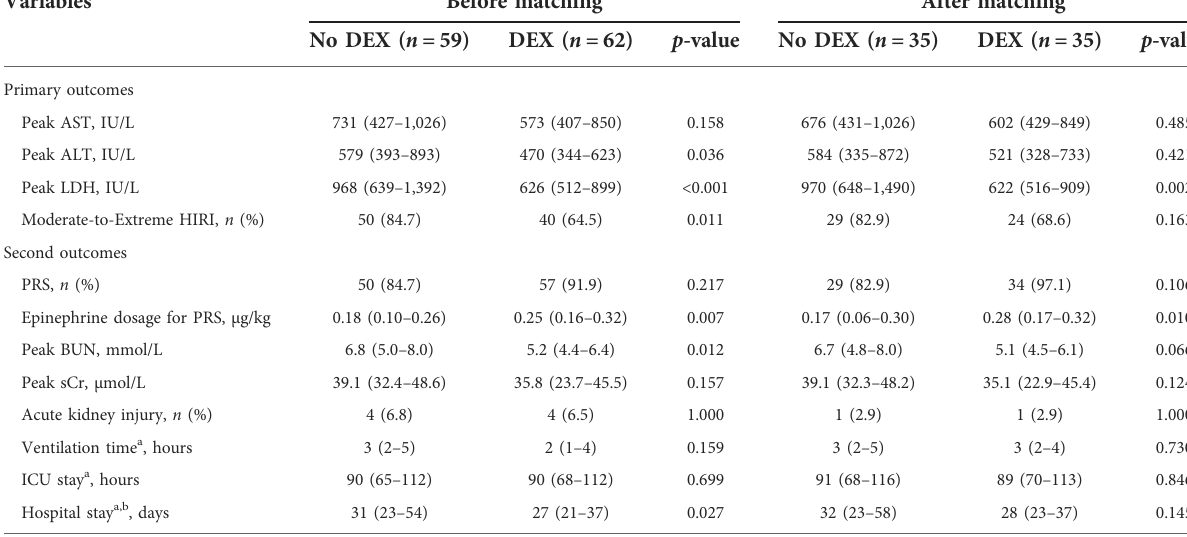
TABLE 2 Comparison of study outcomes before and after propensity score matching.